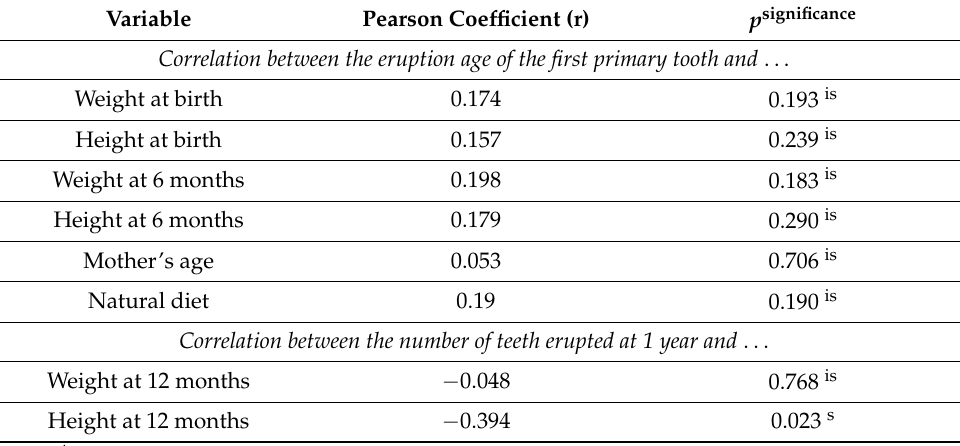
Table 5. The correlation between the timing of eruption of the first primary tooth and for the number of teeth at one year. Variable Pearson Coefficient (r) p significance Correlation between the eruption age of the first primary tooth and . . . Weight at birth 0.174 0.193 is Height at birth 0.157 0.239 is Weight at 6 months 0.198 0.183